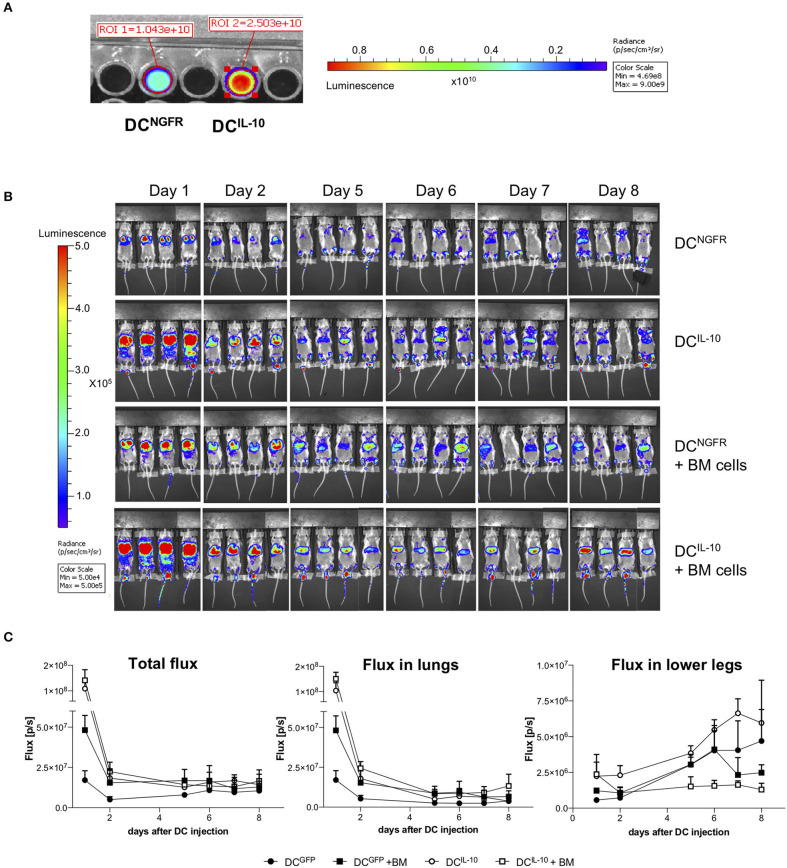
Biodistribution of transduced DC. Female Balb/c BM cells were transduced at day 2 during DC differentiation with bdLV encoding for luciferase and IL-10 (DCIL−10) or ΔNGFR (DCNGFR). (A) Transduction efficiency was evaluated adding luciferin to a well with 2 × 105 DCs and reading the bioluminescent signal. (B,C) Female Balb/c mice were lethally irradiated and intravenously injected with luciferase-transduced DCNGFR or DCIL−10 (2 × 106 cells/mouse) alone or in combination with autologous BM cells (107 cells/mouse) (n = 4 mice for group). DC localization was monitored with bioluminescence imaging (BLI) at the indicated time points. Single mice scanning (B) and quantification of BLI at the indicated time points (C) are shown.